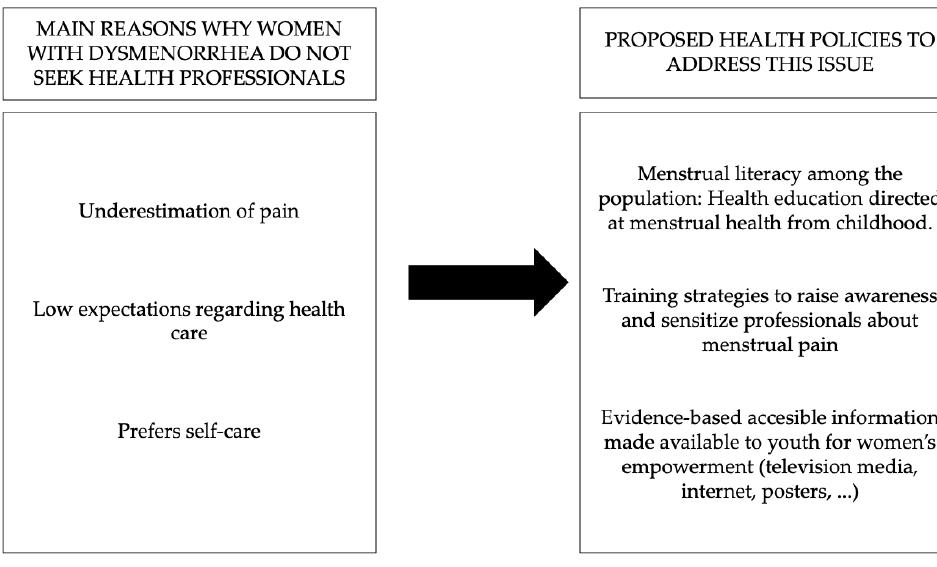
Figure 1. Main reasons why women with dysmenorrhea do not seek health consultations and proposed health policies to address this issue.